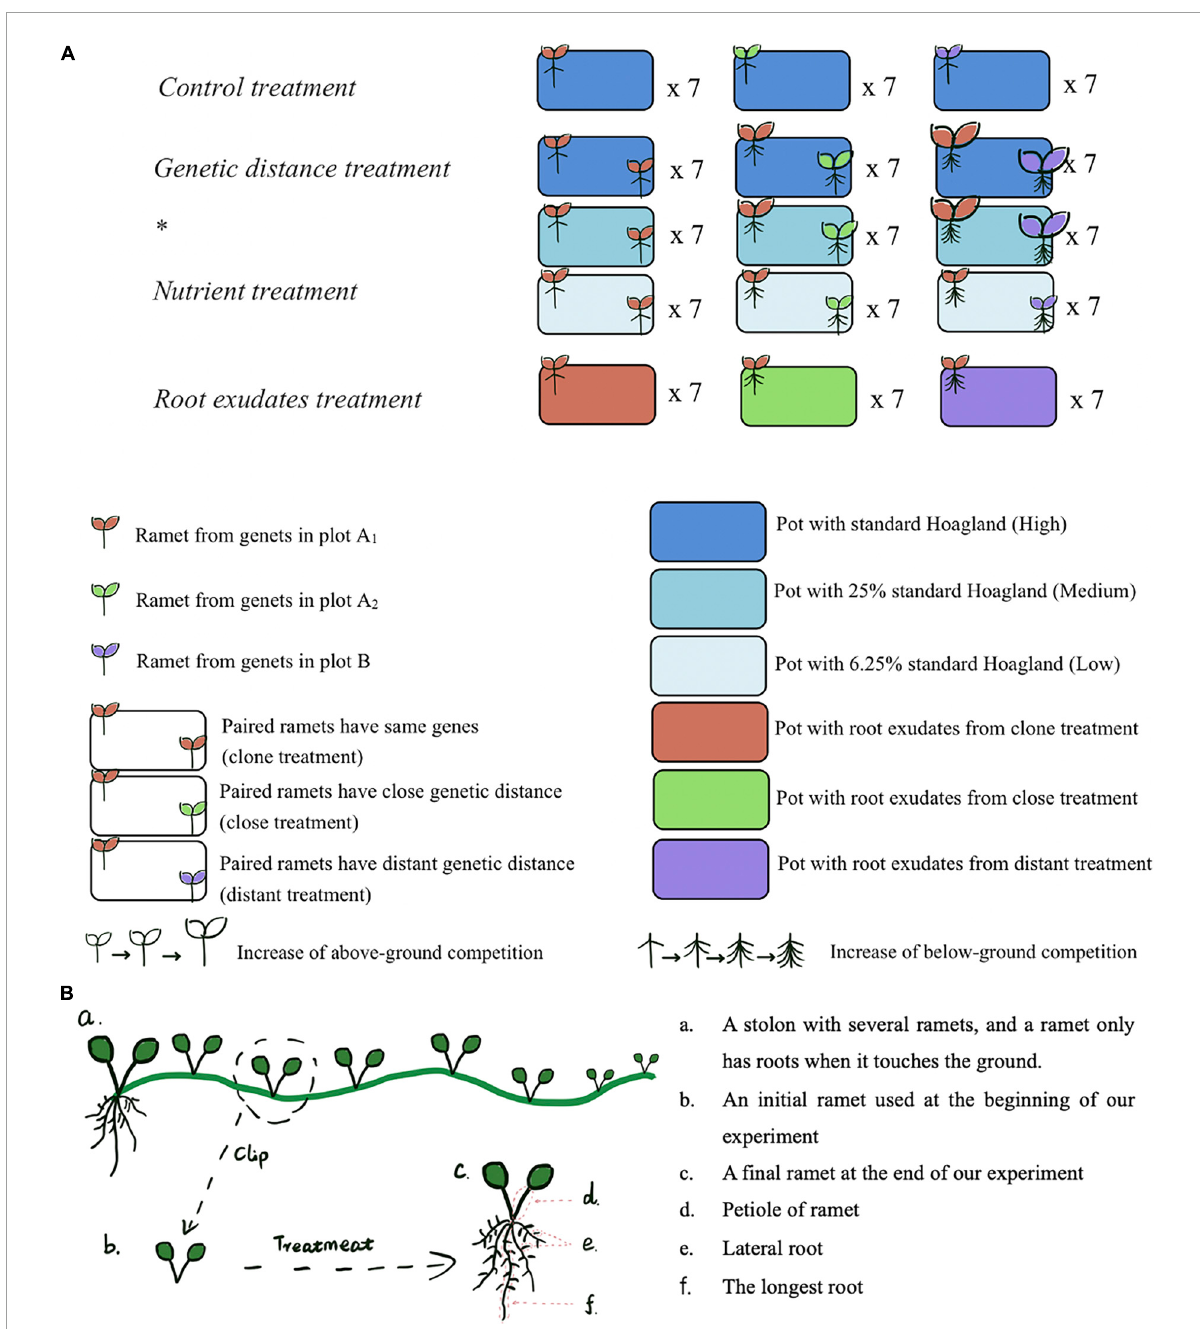
FIGURE1 (A) Design of experimental units. After the Genetic distance treatment * Nutrient treatment, we kept the solution of the high nutrient level, which includes root exudates from ex-target and its neighbor, then put a ramet with the same gene of the ex-target in each pot as the Root exudates treatment. (B) A plant growth diagram showing the ramet material used in our experiment.